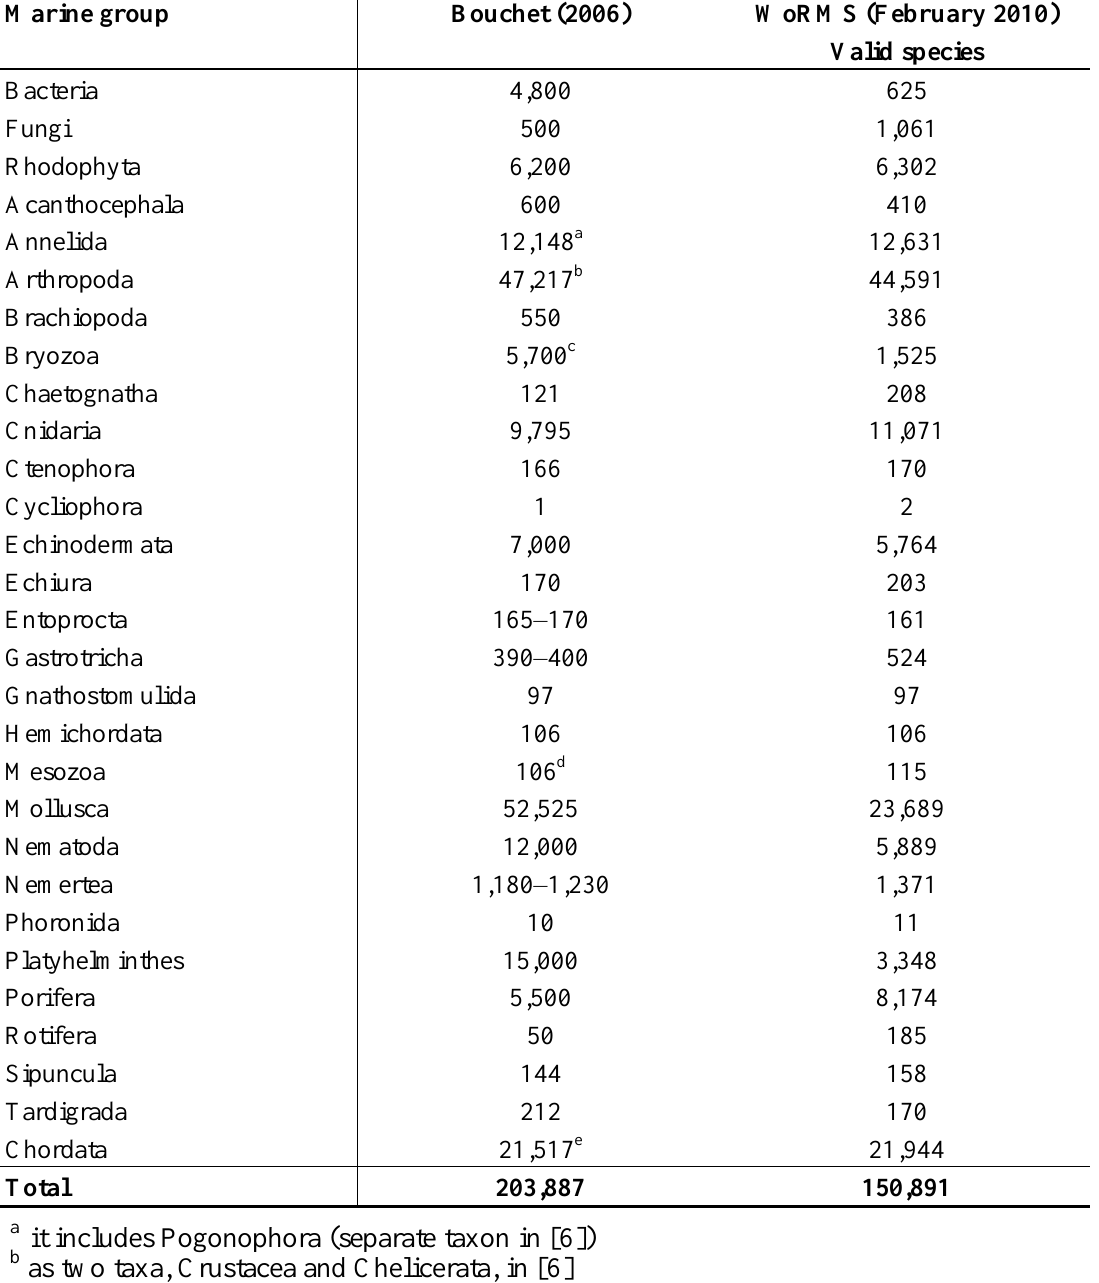
Table 1. Global numbers of marine species per taxon according to Bouchet [6] and WoRMS. Only taxa present on both lists were